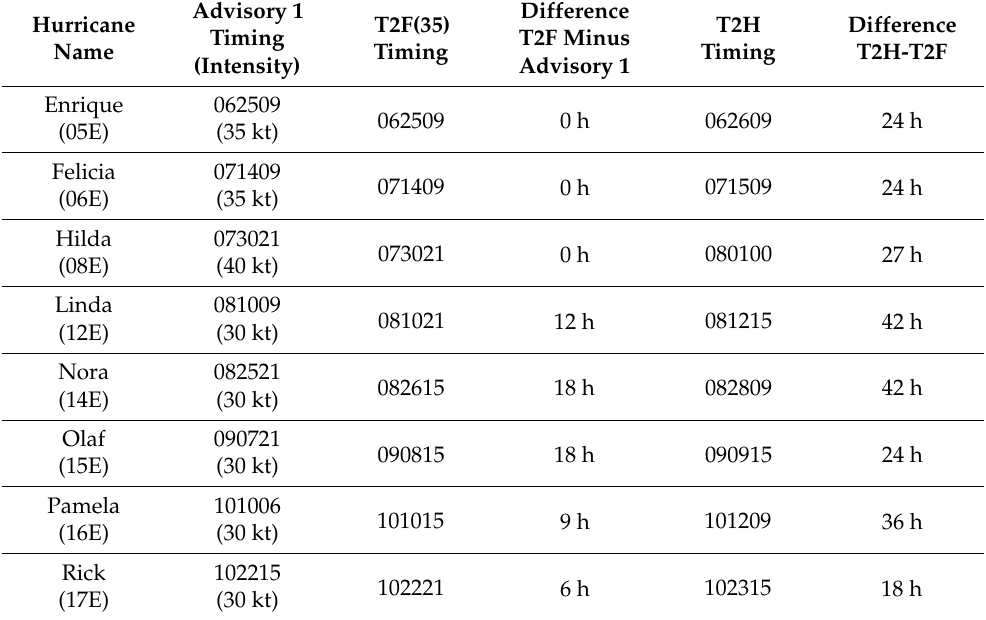
Table 1. National Hurricane Center advisories for pre-Hurricanes during the eastern North Pacific 2021